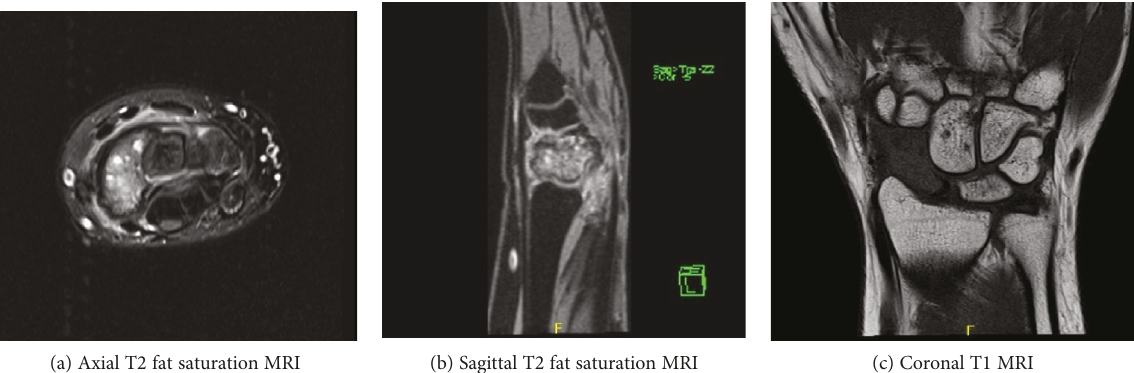
Figure 2: Axial T2 fat saturation (a), sagittal T2 fat saturation (b), and coronal T1 (c) MRI sequences of the right wrist, demonstrating a marrow-replacing bone lesion within the scaphoid.